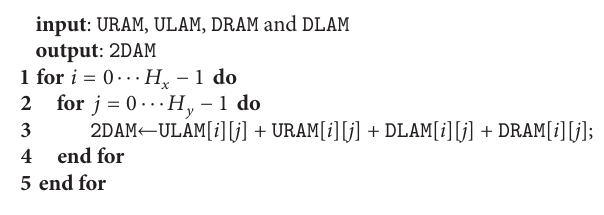
Algorithm 5: EAC heuristic: Compute 2DAM()